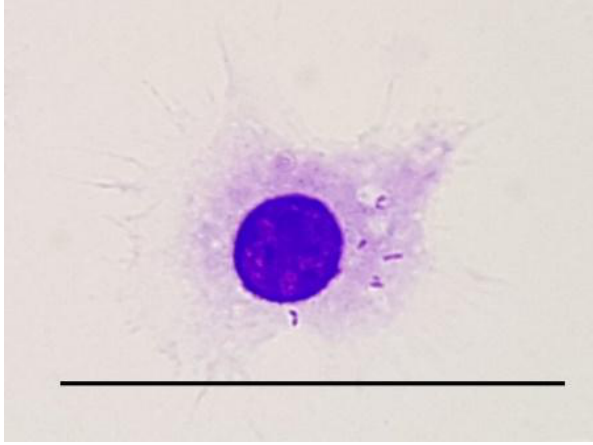
Figure 5. The macrophage of the RAW264.7 cell line infection with T. pyogenes . Staining using the Giemsa–MayGrünwald method; scale bar = 20 µ m (photo courtesy of Anna Hupało-Sikorska,